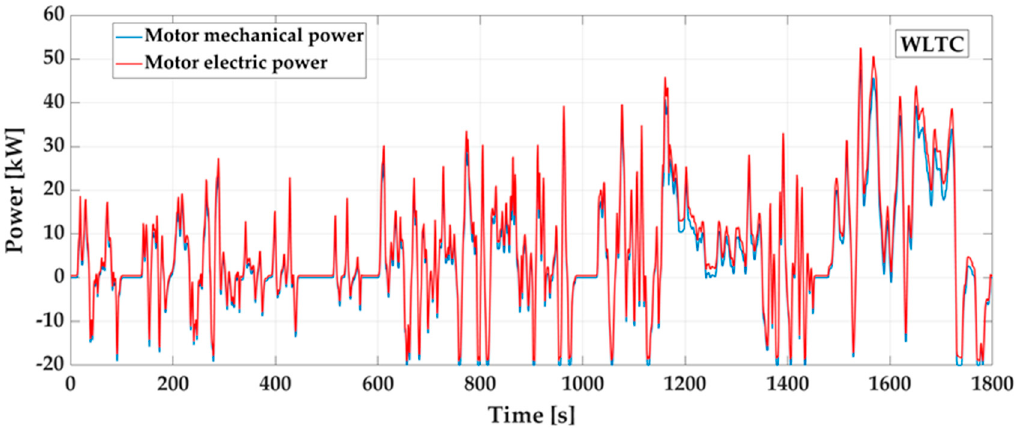
Figure 7. Motor electric and mechanical power vs. time for WLTC in the case of a single speed gearbox.